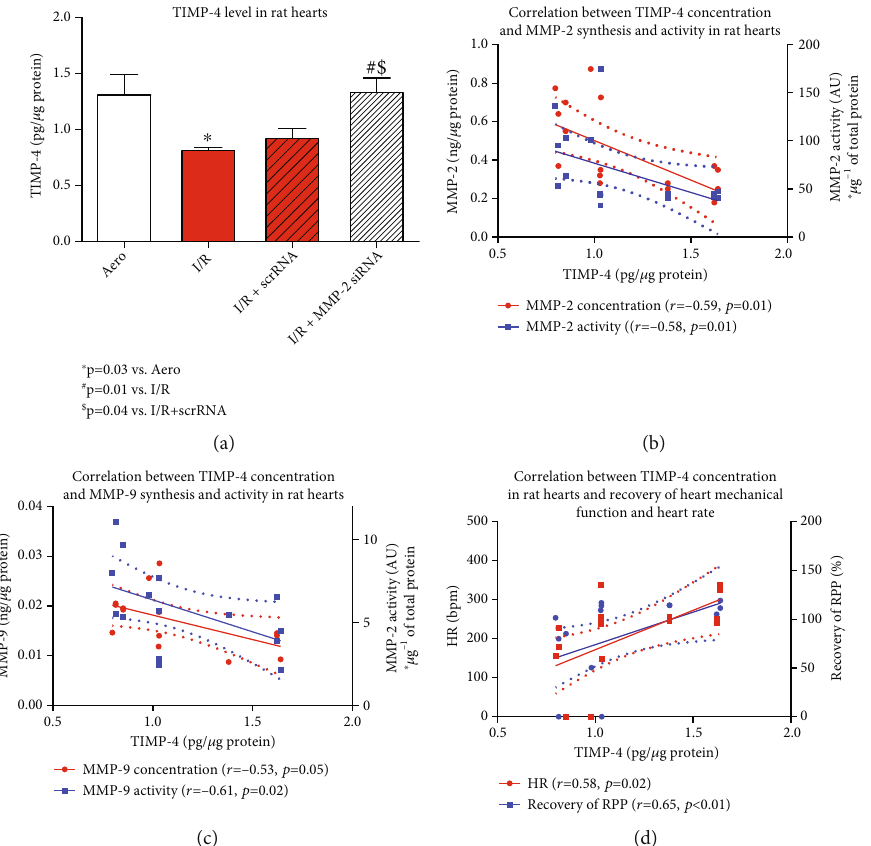
Figure 6: TIMP-4 level in rat hearts (a). Correlation between TIMP-4 level and MMP-2 (b) and MMP-9 (c) synthesis/activity in rat hearts. Correlation between TIMP-4 level in rat hearts and HR/RPP (d). Straight line: standard curve; dotted line: 95% con fi dence band. Aero: aerobic control group; I/R: ischemia/reperfusion; MMP-2: matrix metalloproteinase 2; TIMP-4: endogenous tissue inhibitor of matrix metalloproteinase